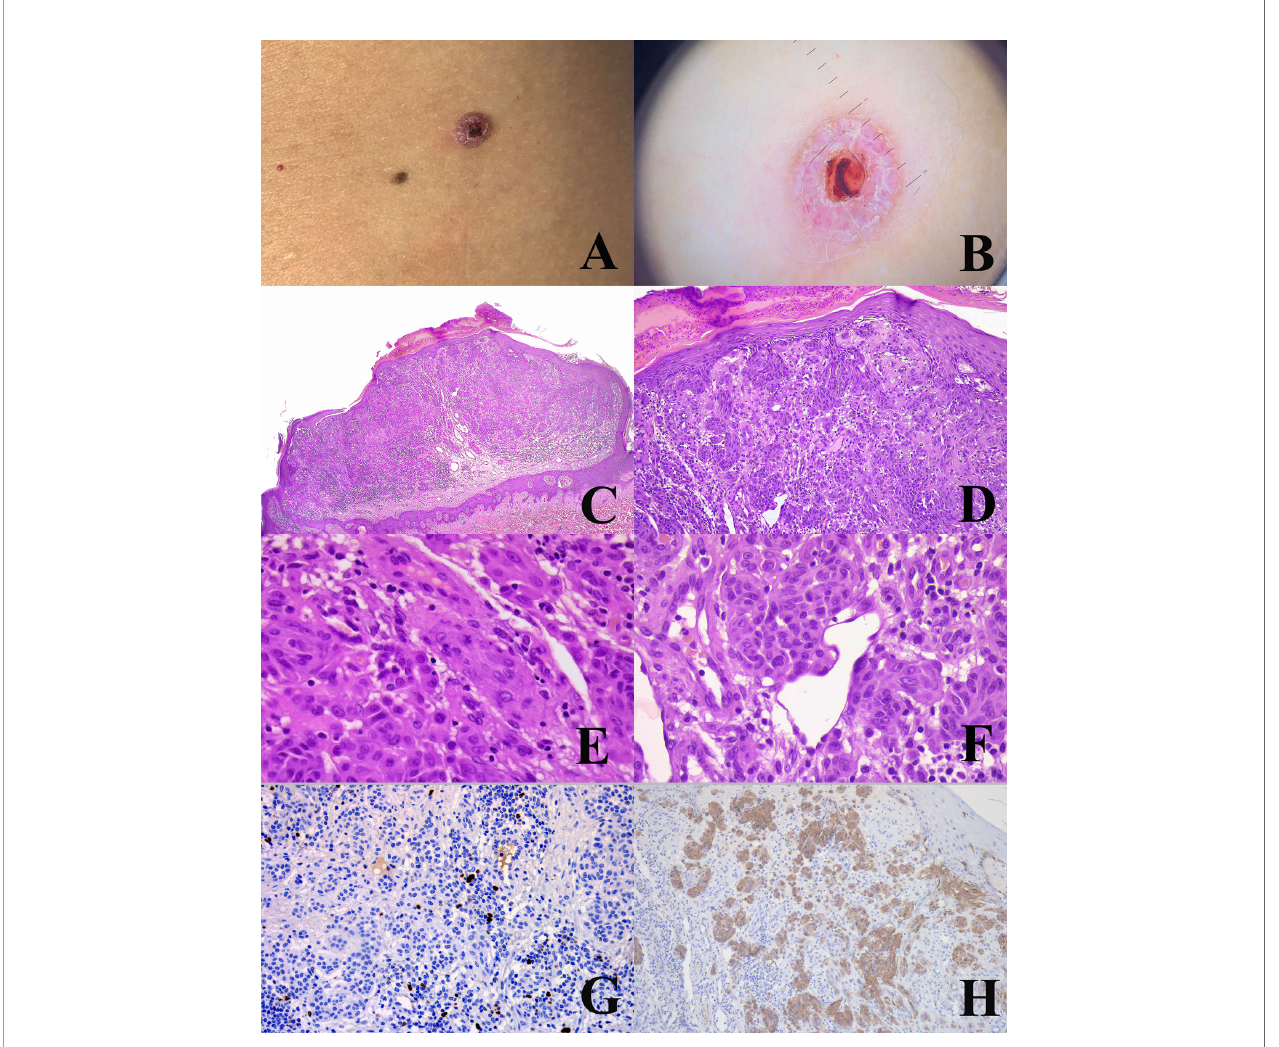
FIGURE 6 | Woman, 22 years.Anulceratednodule oftheright fl ank (A) dermoscopicallycharacterizedbykeratoacanthoma-like featureswithvesselssurroundedbyawhite halo (B) . Histopathologically, thetumor has anirregularlynodular, exophytic silhouette withanepidermal “ collarette ” ,a super fi cial crust, and a “ brisk ” in fl ammatoryin fi ltrateinthe dermis( C ; hematoxylin – eosin, ×25); the super fi cialnestsare veryirregularlycon fl uentwithno sharpcircumscriptionfrom the overlying epidermis ( D ; hematoxylin – eosin, ×250); dermalmelanocytes show a “ spitzoid ” morphology, withspindle( E ; hematoxylin – eosin, ×400) andepthelioid ( F ; hematoxylin – eosin, ×400) cells, bothwithreativelyabundantand eosinophiliccytoplasms. Inspiteoftheseverearchitectural atypia, theproliferationrate ofthe tumor (Ki67-positive dermalmelanocytes) islow (G) ×250); however, the tumor is notanatypical Spitztumor, buta classicalnodular melanoma because itispositivetotheantibodyanti-BRAFv600e-mutatedprotein (H)